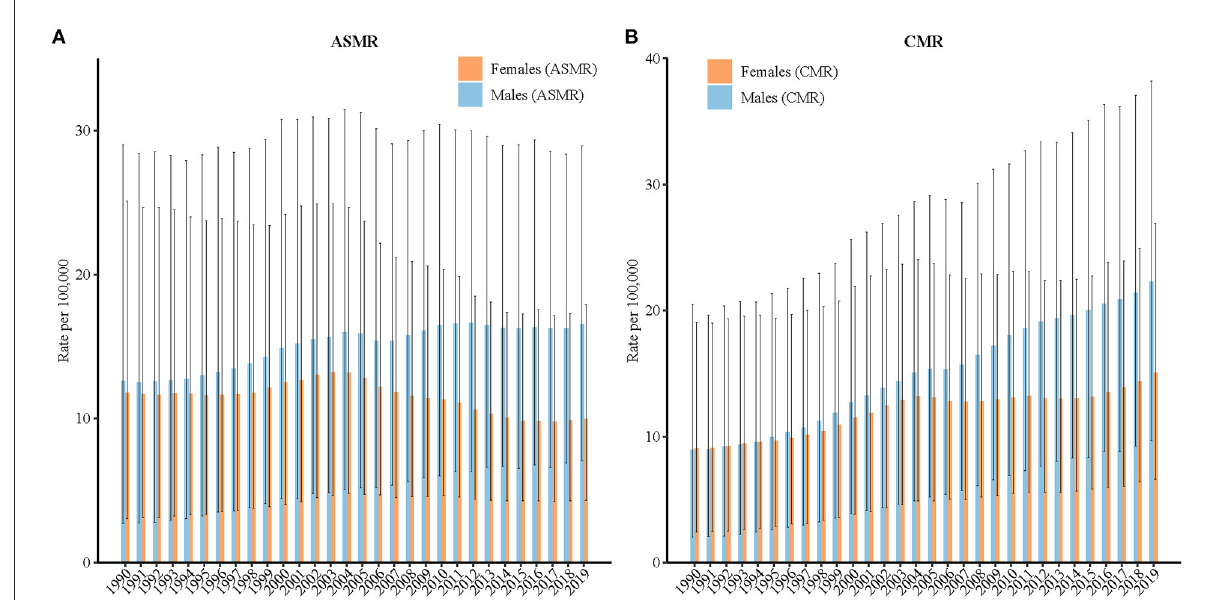
FIGURE1 Trends of the (A) age-standardized mortality rates (ASMRs) and (B) crude mortality rates (CMRs) per 100,000 population for high-BMI-attributable stroke mortality by sex in China, 1990–2019. The ASMR was standardized to the GBD 2019 (Global Burden of Disease Study 2019) global age-standard